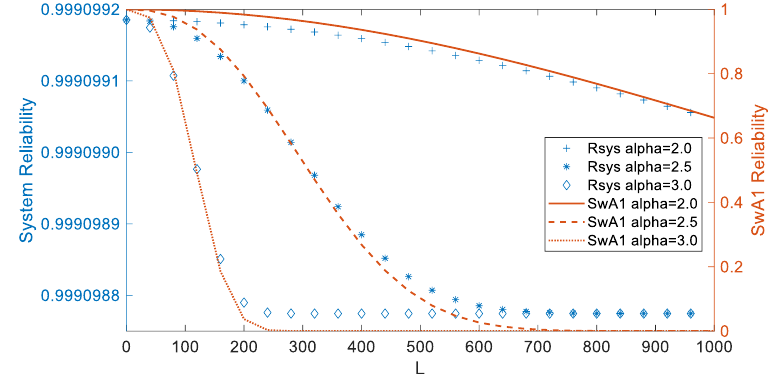
Figure 10 . R sys ( L ) and R SwA1 ( L ) under different α SwA1 at t=